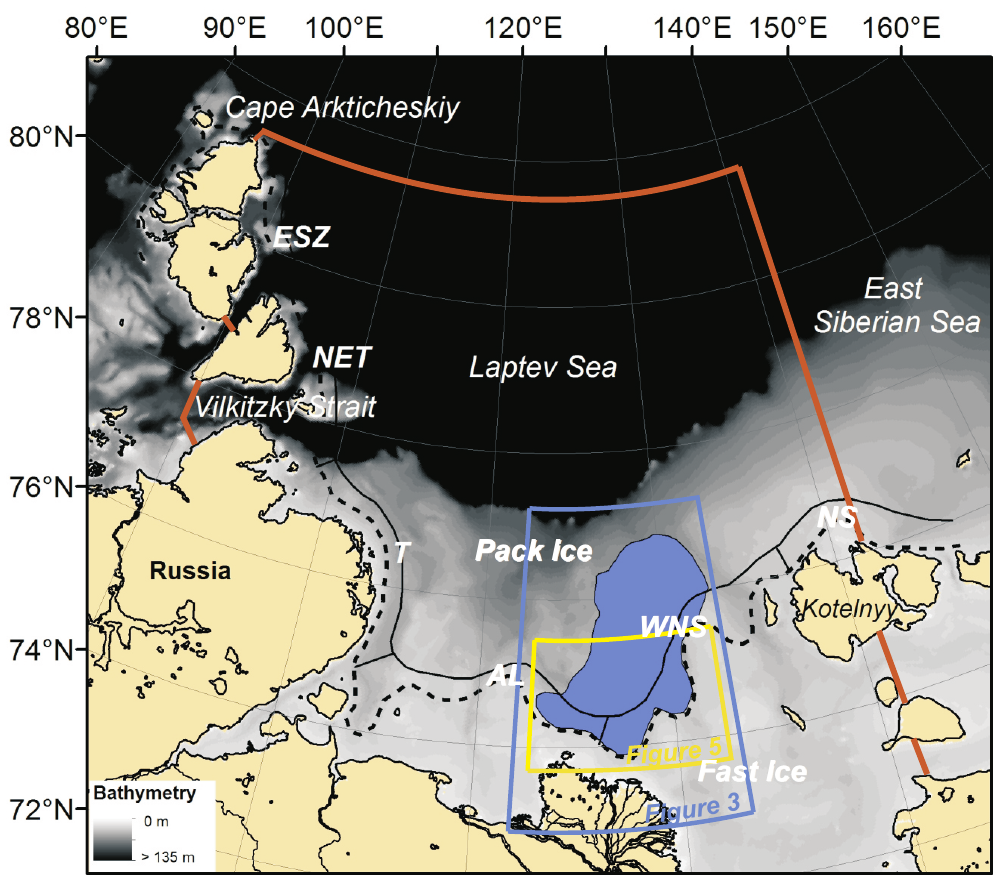
Fig. 1. Map of the Laptev Sea showing three distinct sea-ice components: fast ice, pack ice, and polynyas. Black solid and dashed lines delineate the mean lateral extent of fast ice and beginning of pack ice, respectively, at the end of winter. Polynyas that form between the two lines are the Anabar–Lena (AL), eastern Severnaya Zemlya (ESZ), north-eastern Taymyr (NET), New Siberian (NS), Taymyr (T), and western New Siberian (WNS) polynyas. Gray scale corresponds to the bathymetry (Smith and Sandwell, 1997). Blue area is the surveyed area comprising sea ice that formed during and after polynya openings between December 2007 and April 2008. Red line defines the outer skirt of the Laptev Sea. The blue and yellow frames indicate the outline of the areas shown in Figs. 3 and